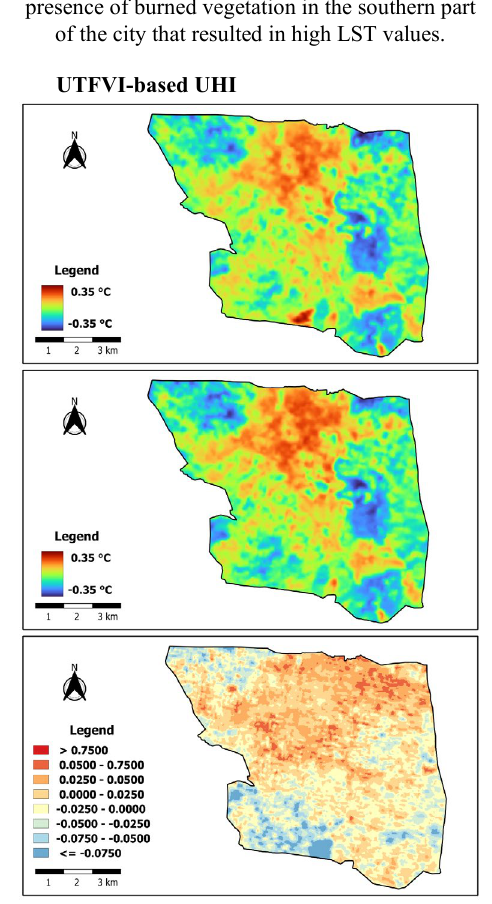
Figure 6 . Spatial variations of UTFVI in Baguio City on March 25, 2019 (top) and March 09, 2022 (middle), and the difference (bottom) between them. The UHI effect in the city has increased in the current year, particularly in the central business